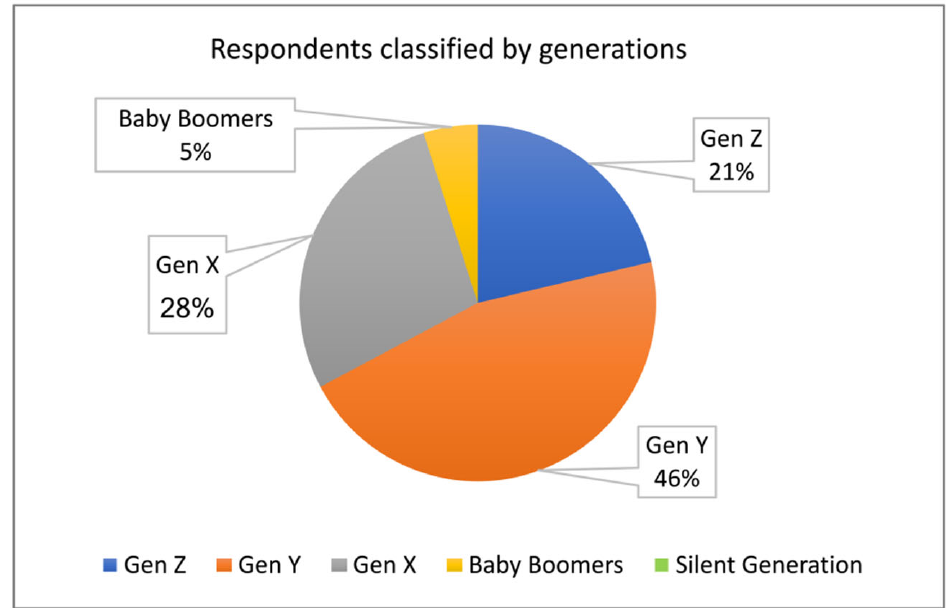
Figure 11. Numbers of respondents classified by generation, shown in percentage.